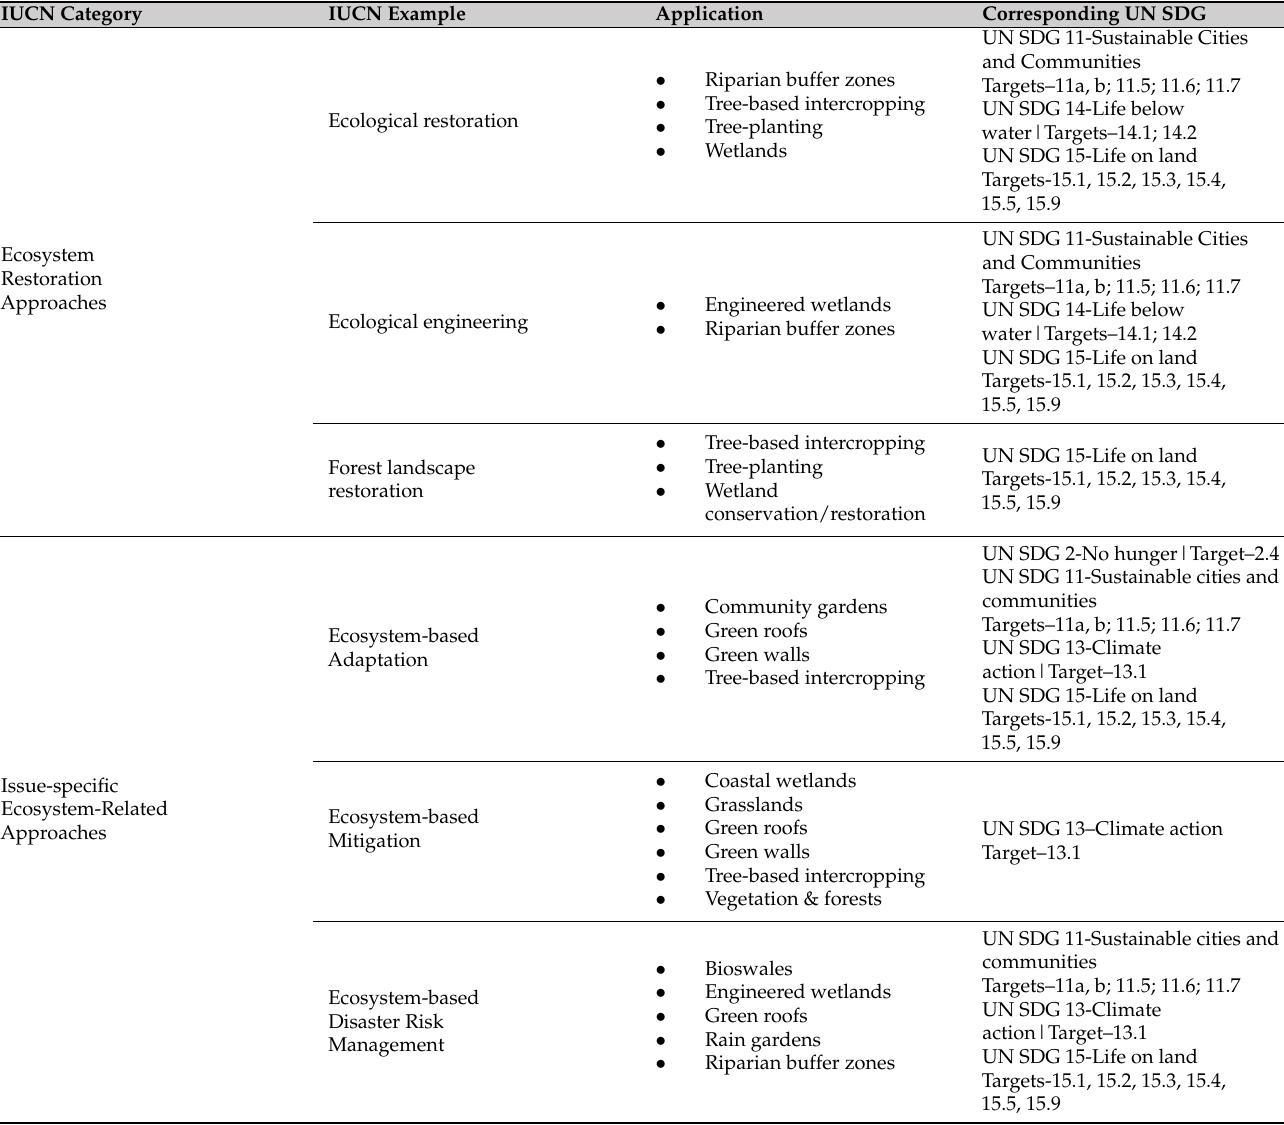
Table 2. Typology of Nature-based Solutions